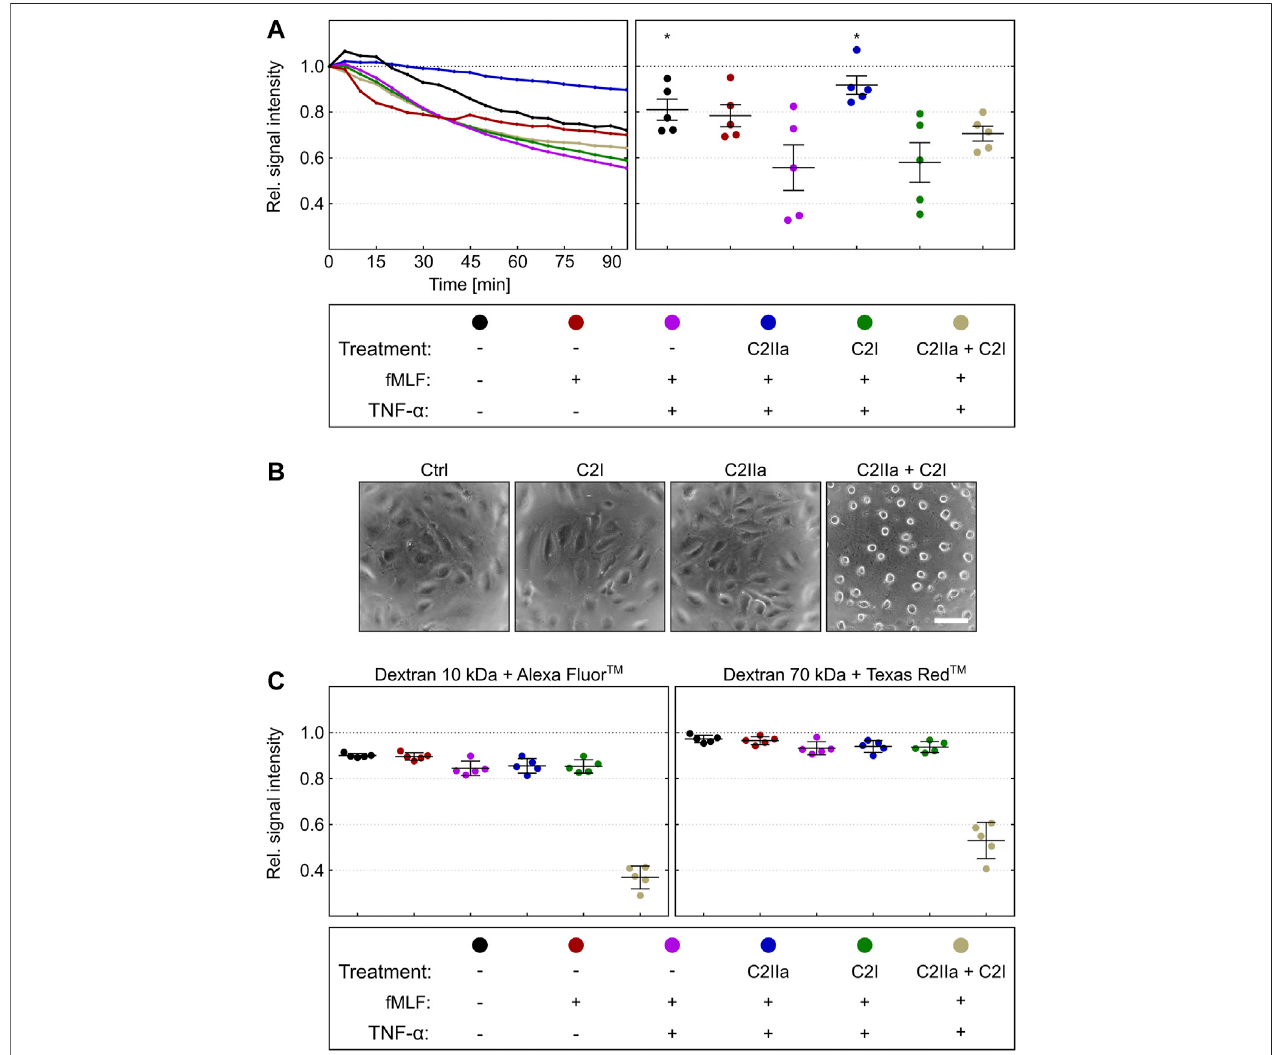
FIGURE7| EffectofcompleteC2toxinanditssinglecomponentsC2IIaandC2IonthetransendothelialchemotactictranslocationofprimaryhumanPMNs exvivo andonbarrierintegrity. (A) Anendothelialmonolayer(HUVEC)wasculturedon fi lterinsertswith3 µmporesizeandactivatedbyTNF α (10 ng/ml).Calcein-stainedPMNs were pre-incubated in the presence or absence of C2IIa (2 μ g/ml), C2I (1 μ g/ml) or both components (2 μ g/ml C2IIa + 1 μ g/ml C2I) for 2 h and subsequently seeded on the apical site of endothelial cells. PMN chemotaxis towards the lower chamber was stimulated by addition of fMLF (10 nM). Calcein fl uorescence was measured fromthetopimmediatelyafterstimulationoveraperiodof95 min.Thedeclineinsignalintensityisconsideredtobeameasureofthefractionofcellsmigratedthroughthe endothelialmonolayerwithin95 min.Itscomputationisdescribedinthemethodssection.Theleftpanelshowsonerepresentativerecording.Therightpanelsummarizes results of fi ve independent experiments after 95 min. Values are given as mean ± SEM (n = 5). Signi fi cance was tested with Wilcoxon matched-pairs signed rank test (one-tailed) by GraphPad software (* p < 0.05). Statistical tests refer to samples treated with fMLF + TNF α . (B) Representative pictures of HUVEC cells in a monolayer whichweretreatedfor3 hat37 ° Cwithsolvent(Ctrl),C2IIa(2 μ g/ml),C2I(1 μ g/ml)orbothcomponents(2 μ g/mlC2IIa+1 μ g/mlC2I). (C) Thetreatmentoftheco-culture (HUVEC) with C2IIa does not increase transendothelial fl uxes of fl uorescence dye-labelled dextrans with molecular weights of either 10 kDa or 70 kDa (left and right panels, respectively). In contrast to the single C2 toxin components, the whole toxin (2 μ g/ml C2IIa + 1 μ g/ml C2I) disrupted the endothelial barrier-integrity. Values are given as mean ± SEM of fi ve independent experiments (n = 5).